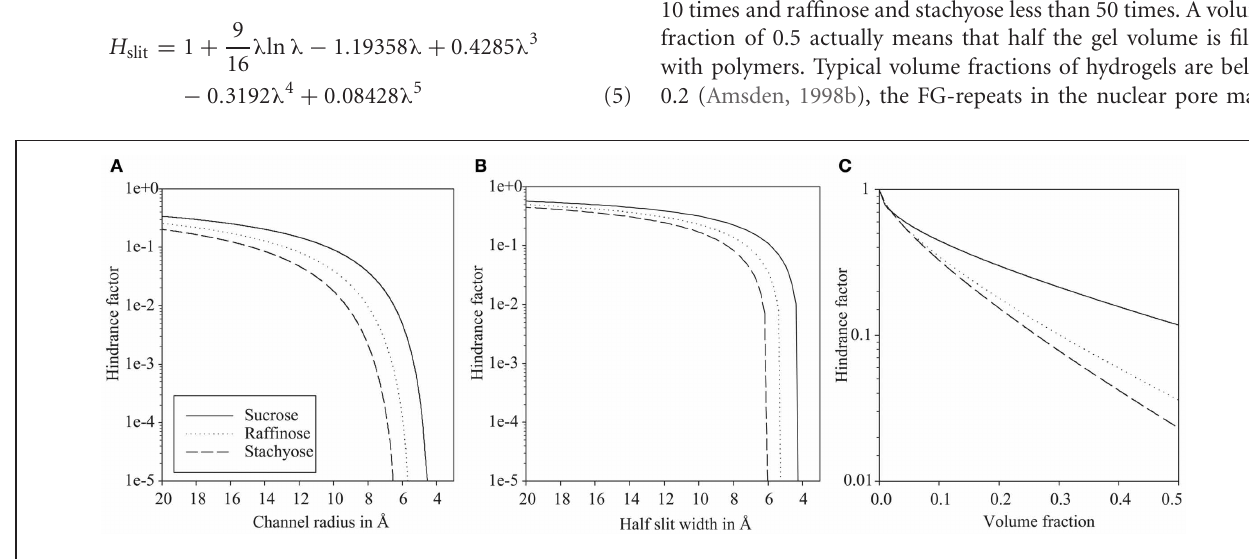
with smaller dimensions in single plasmodesmal channels (A) than in a cytoplasmic sleeve (B) . Hindrance in hydrogels (C) is moderate, even at high volume